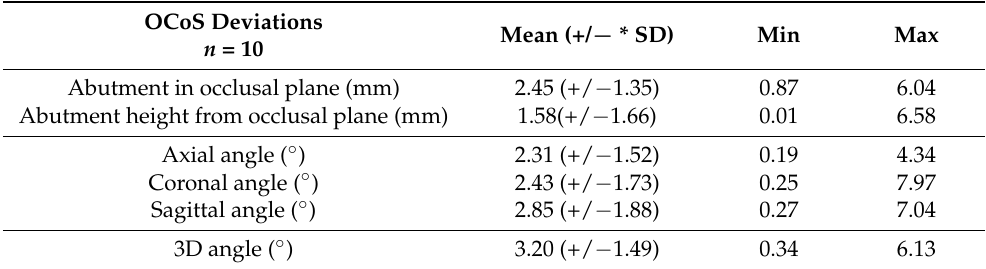
Table 3. Accuracy data. Result of the post-operative analysis. Descriptive statistics of the occlusion coordinate system (OCoS) measurements. * SD, standard